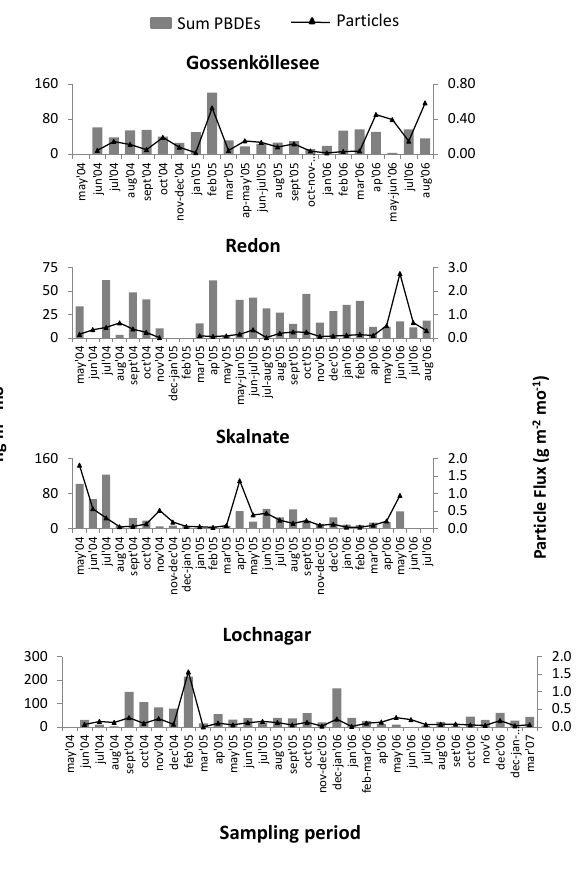
Fig. 2. Temporal variation of particle (straight line) and 6 PBDE (excepting BDE209) deposition fluxes to the studied sites.